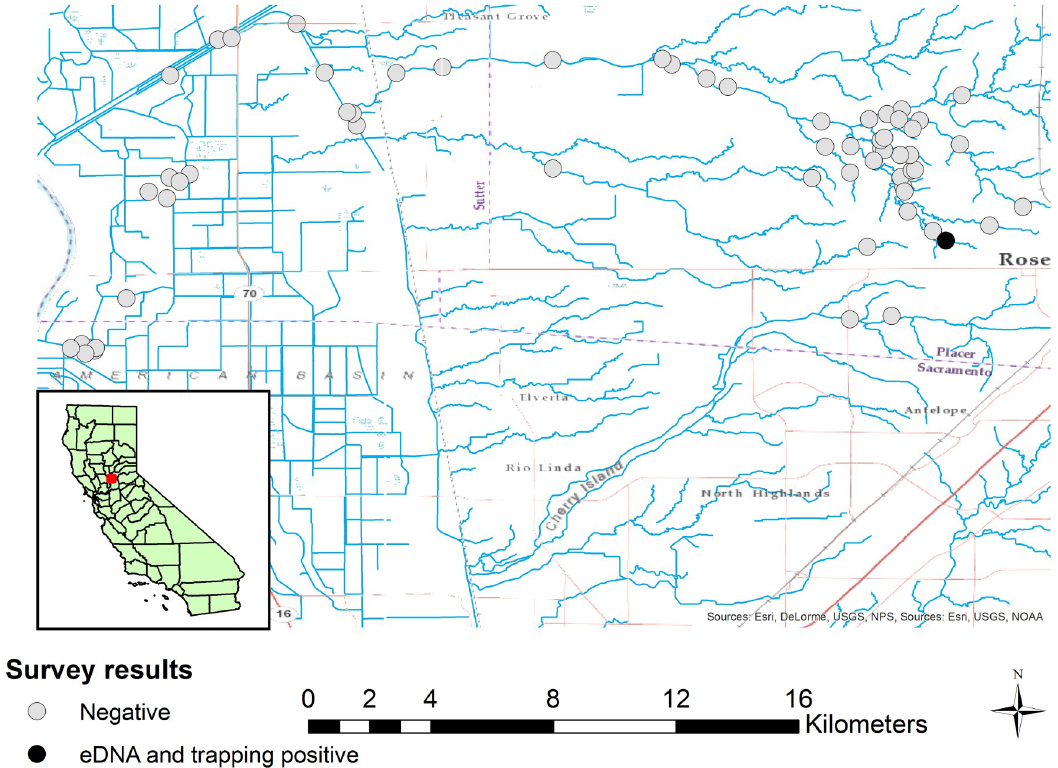
Fig 1. Location of sample sites for Nerodia sipedon . 61 sites sampled for the presence of Nerodia sipedon using eDNA, and for a subset of nine sites, aquatic funnel traps.